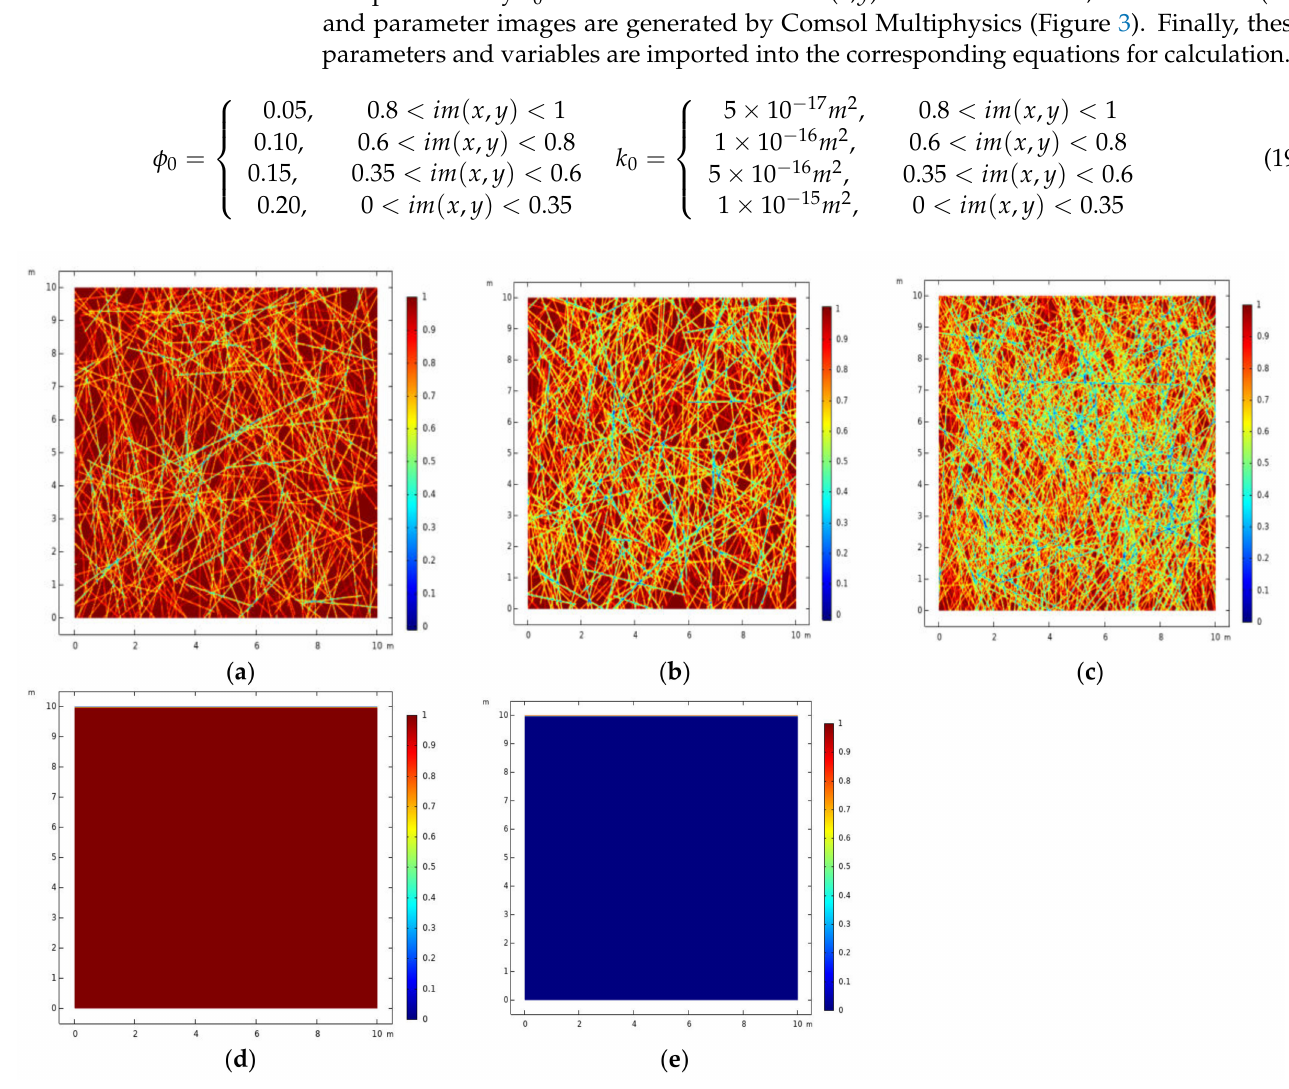
Figure 2. Images of fractured coal seams of different densities. ( a ) m = 0.5; ( b ) m = 0.8; ( c ) m = 1.1; ( d ) m = 0; ( e ) m = ∞ .